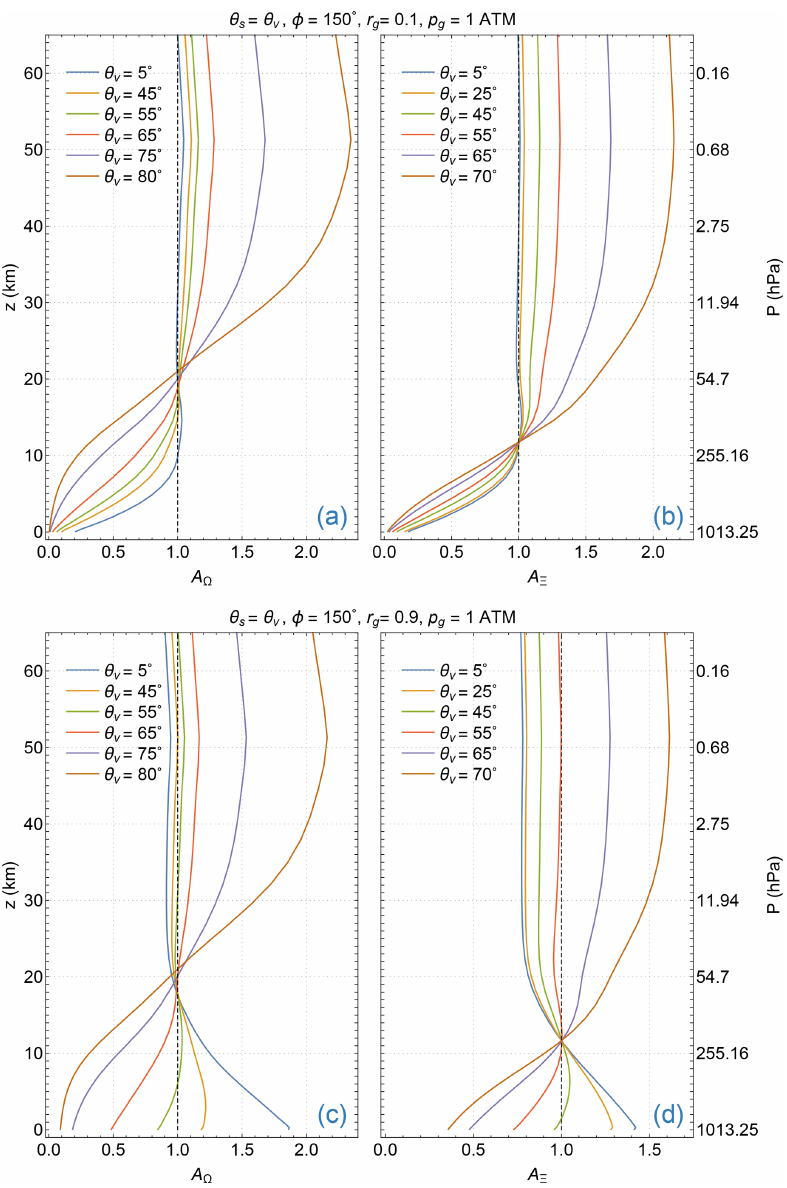
Figure 18. Examples of EPIC total O 3 AKs (a, c) and SO 2 AKs (b, d) as functions of geometric altitude ( z ) above seal level for several VZAs ( θ v ). These AKs are calculated for a molecular atmosphere at midlatitude with 275DU total O 3 and 30DU of SO 2 in a layer (1.5km thick) at 11km altitude over low-reflectance (a, b) and high-reflectance (c, d) Lambertian surfaces. Observing conditions are listed at the top of the